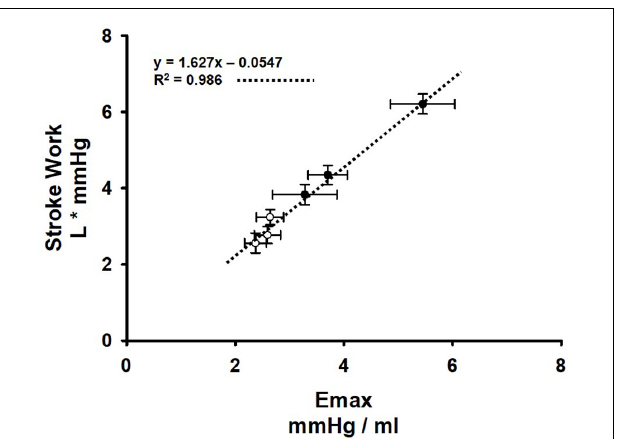
FIGURE 6 | Relationship between ventricular maximal elastance (Emax) and stroke work before (black circles) and after induction of heart failure (white circles) at rest, mild exercise, and muscle metaboreflex activation. A linear regression (dotted line) was performed on these points. and the R 2 value are shown on the plot. Error bars depict standard error of the mean in both directions (Data points were calculated from primary data collected in experiments which were reported in Coutsos et al. (2010, 2013) ( N =